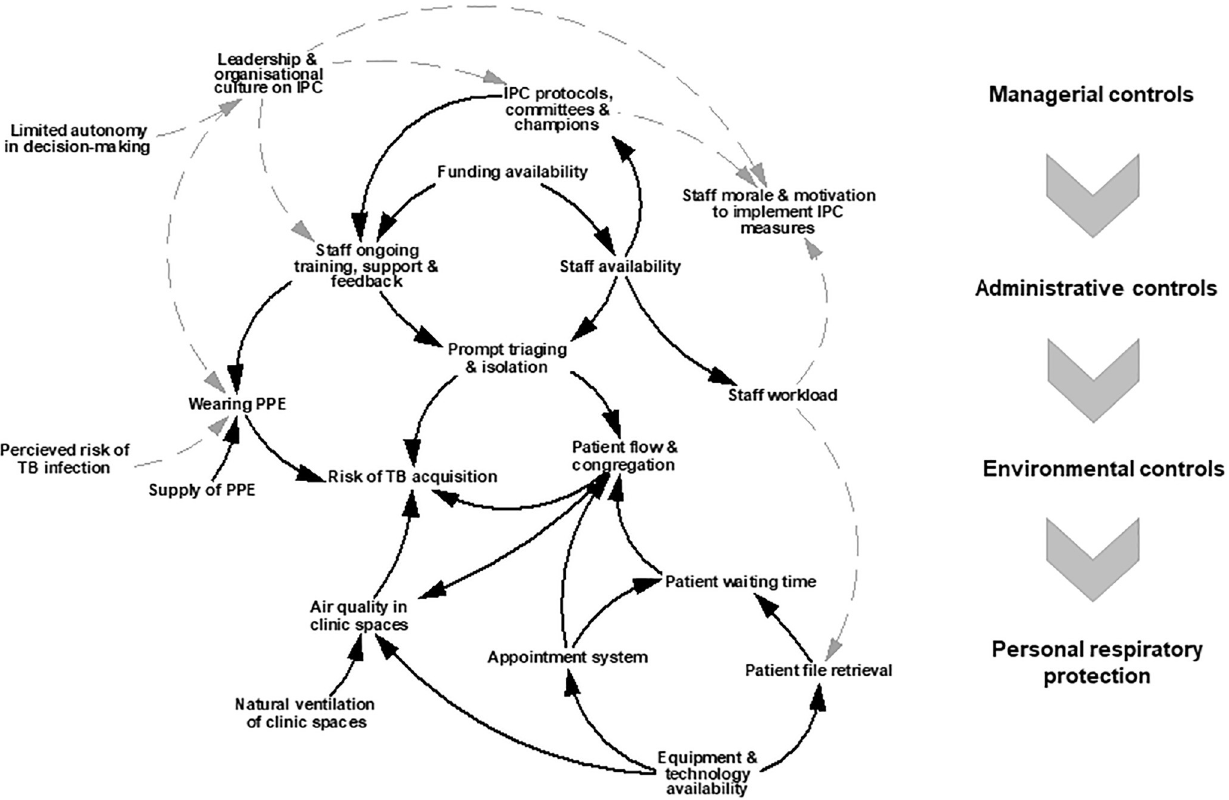
Fig 1. Key interactions between health systems hardware and software components across the hierarchy of TB-IPC controls. Black arrows show tangible interactions between health system hardware components. Dashed grey arrows show less tangible interactions between health systems software and hardware